Question: Give a one-sentence summary of this figure.
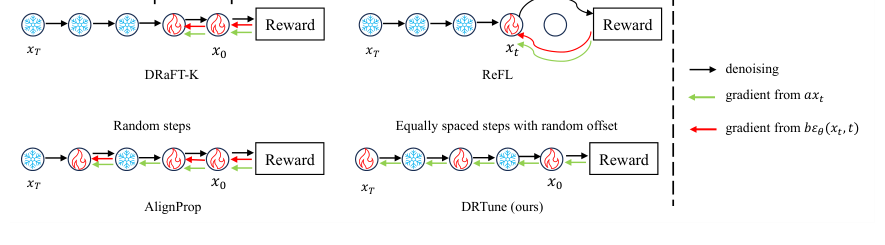
Answer: Comparison between reward training algorithms.